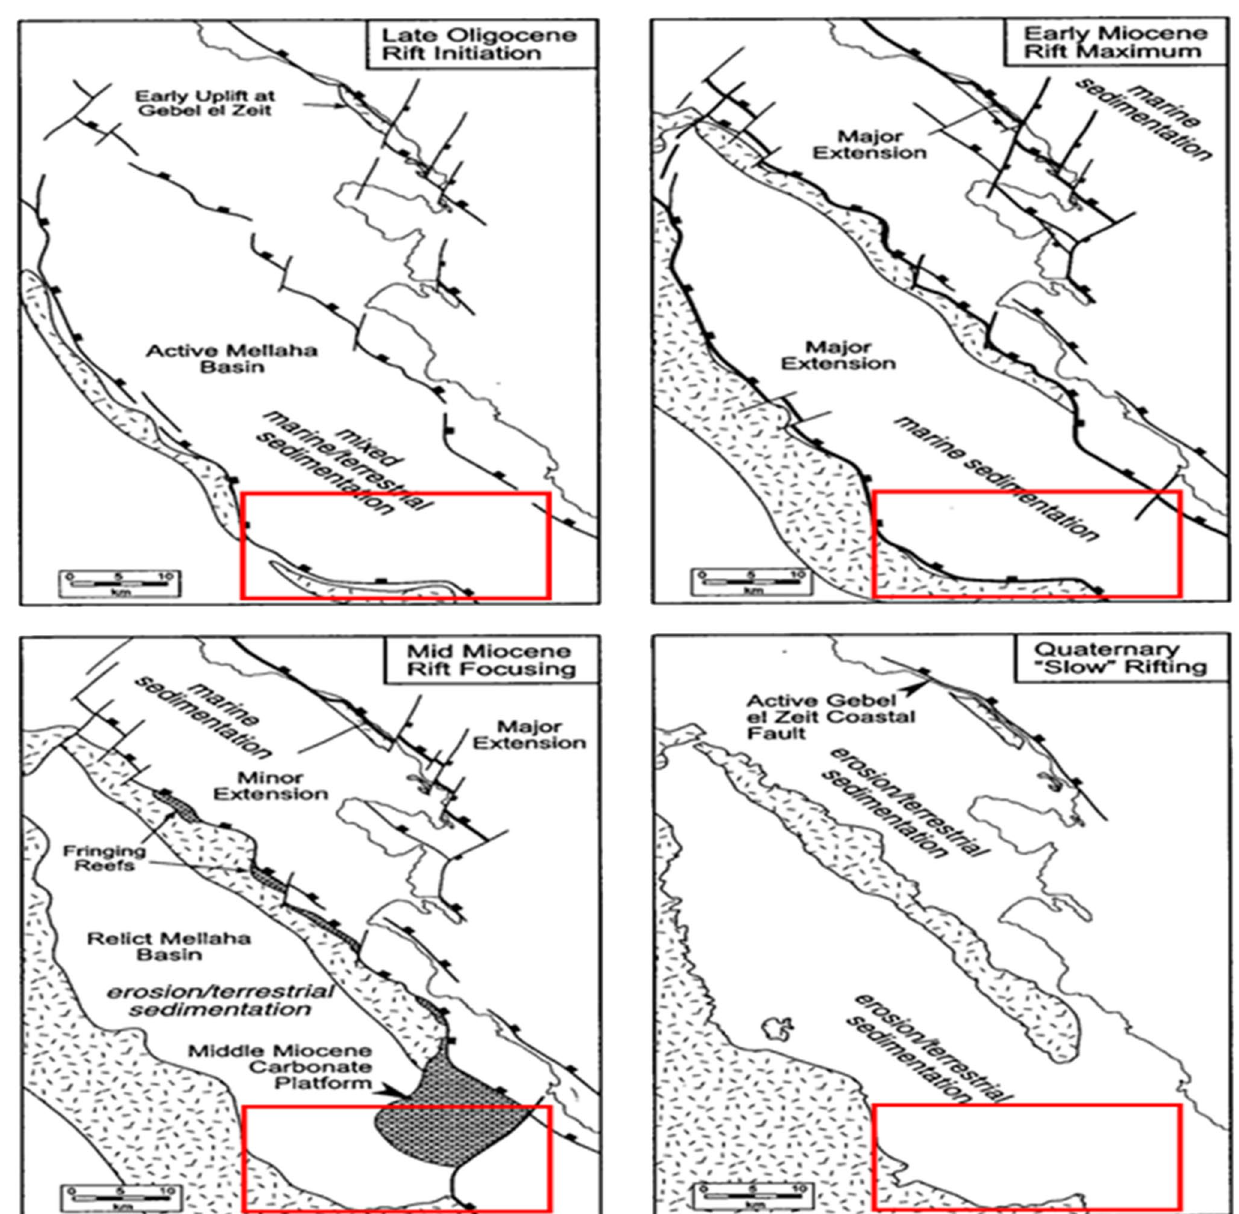
Fig. 2 Fault activity maps for the southwestern margin of the Gulf of Suez based on interpretation of the plate tectonic setting of the Gulf of Suez. Fault movement and associated basin subsidence were pro- gressively focused toward the axis of the rift through time, culminat-